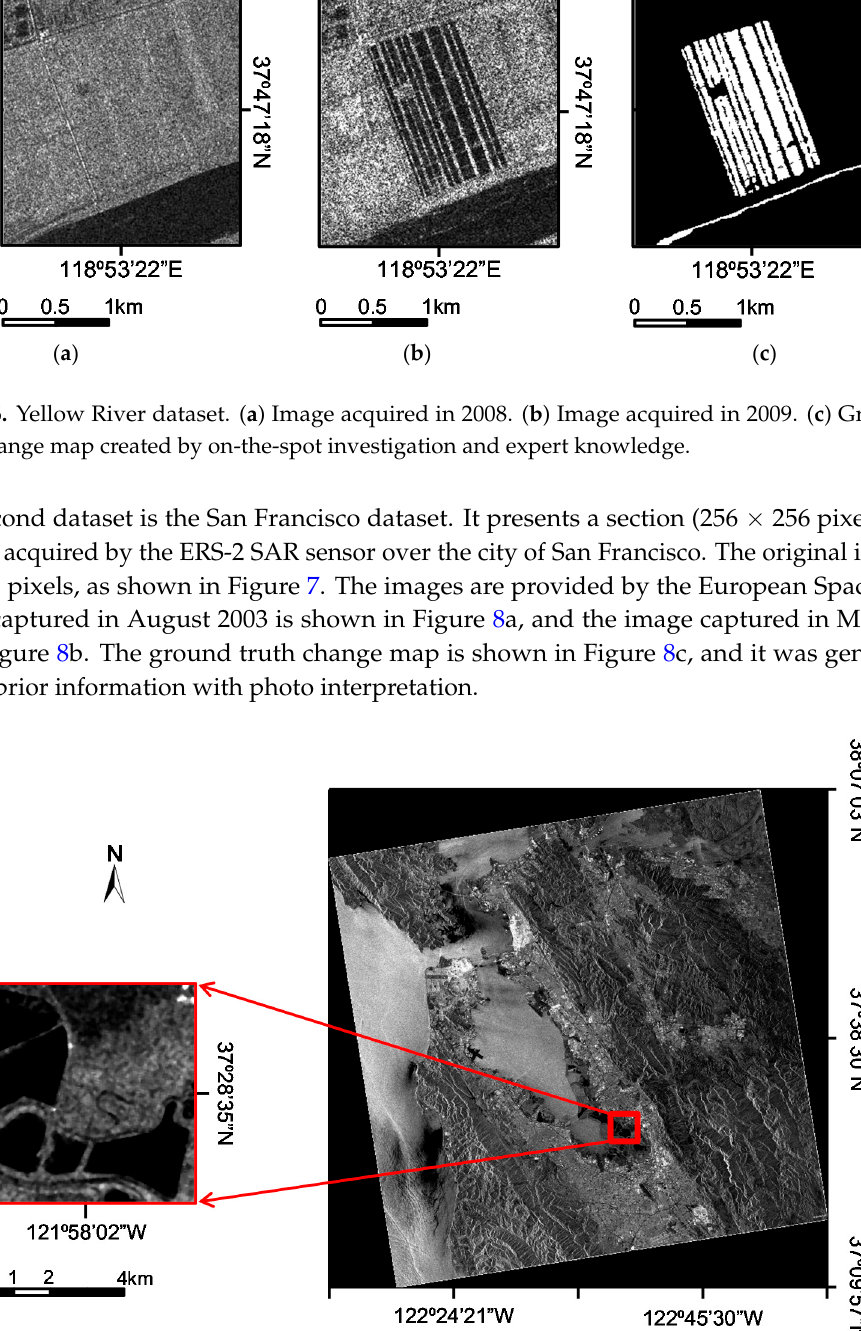
Figure 5. SAR images acquired by Radarsat-2 over the Yellow River Estuary in China.